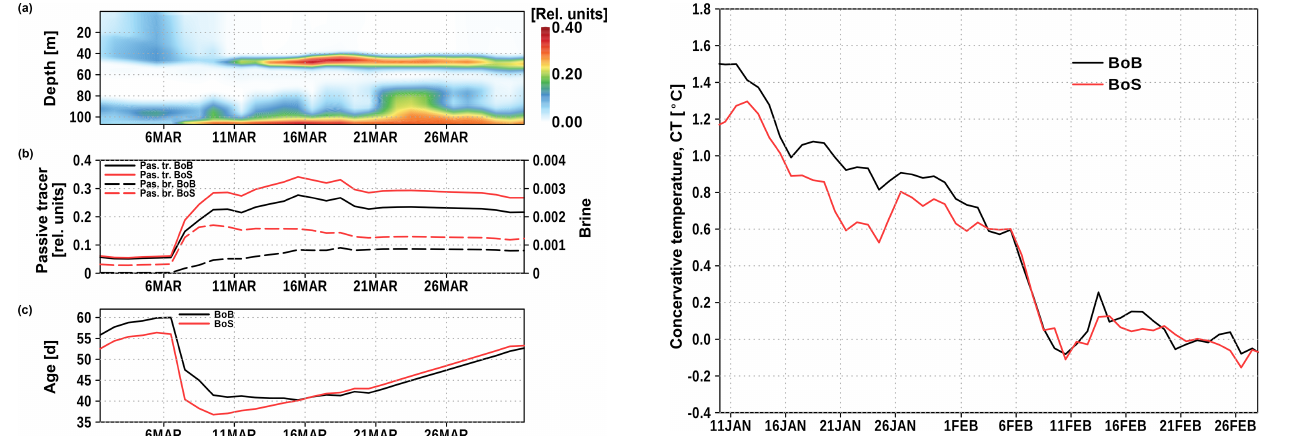
Bay bottom water S BB based on measured salinity.